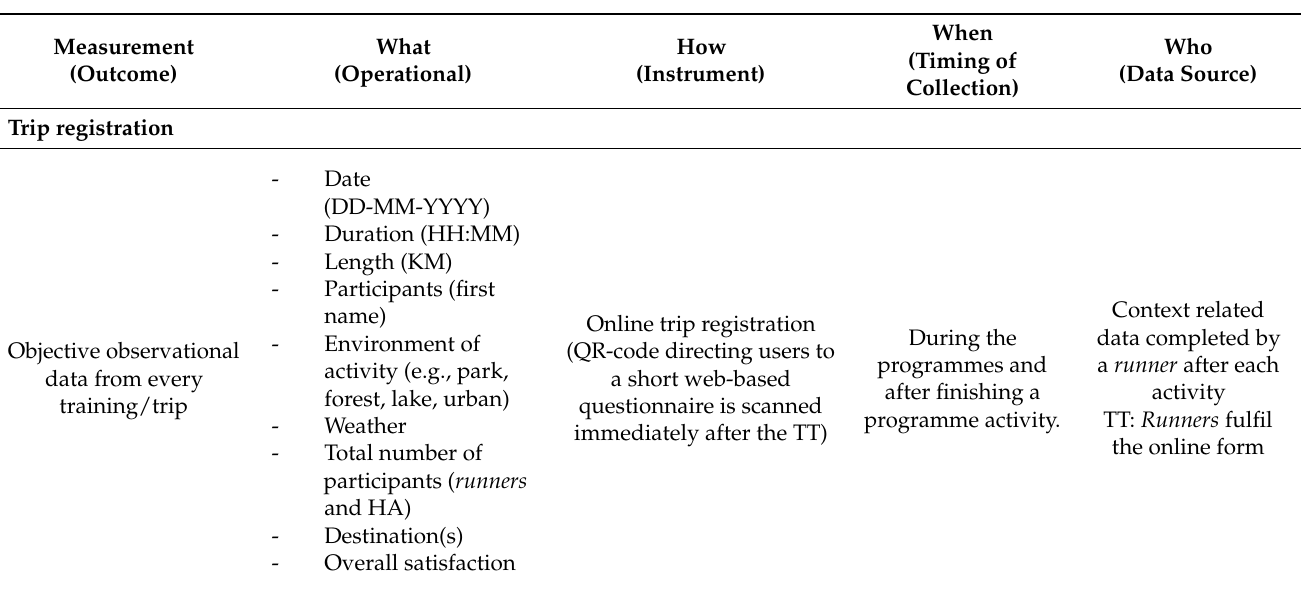
Table 2 summarises the quantitative outcomes (primary, secondary and explorative) for the TT programme. It displays the points in time of data collection as well as instruments used to cover specific areas of the programme theory. Abbreviations: Pre1 = Pretest 1, Pre 2 = Pretest 2 Post = Posttest. TT= Team Twin Programme, HA = Handiathletes. HbA1c = Glycated haemoglobin. OGGT = Oral Glucose Tolerance